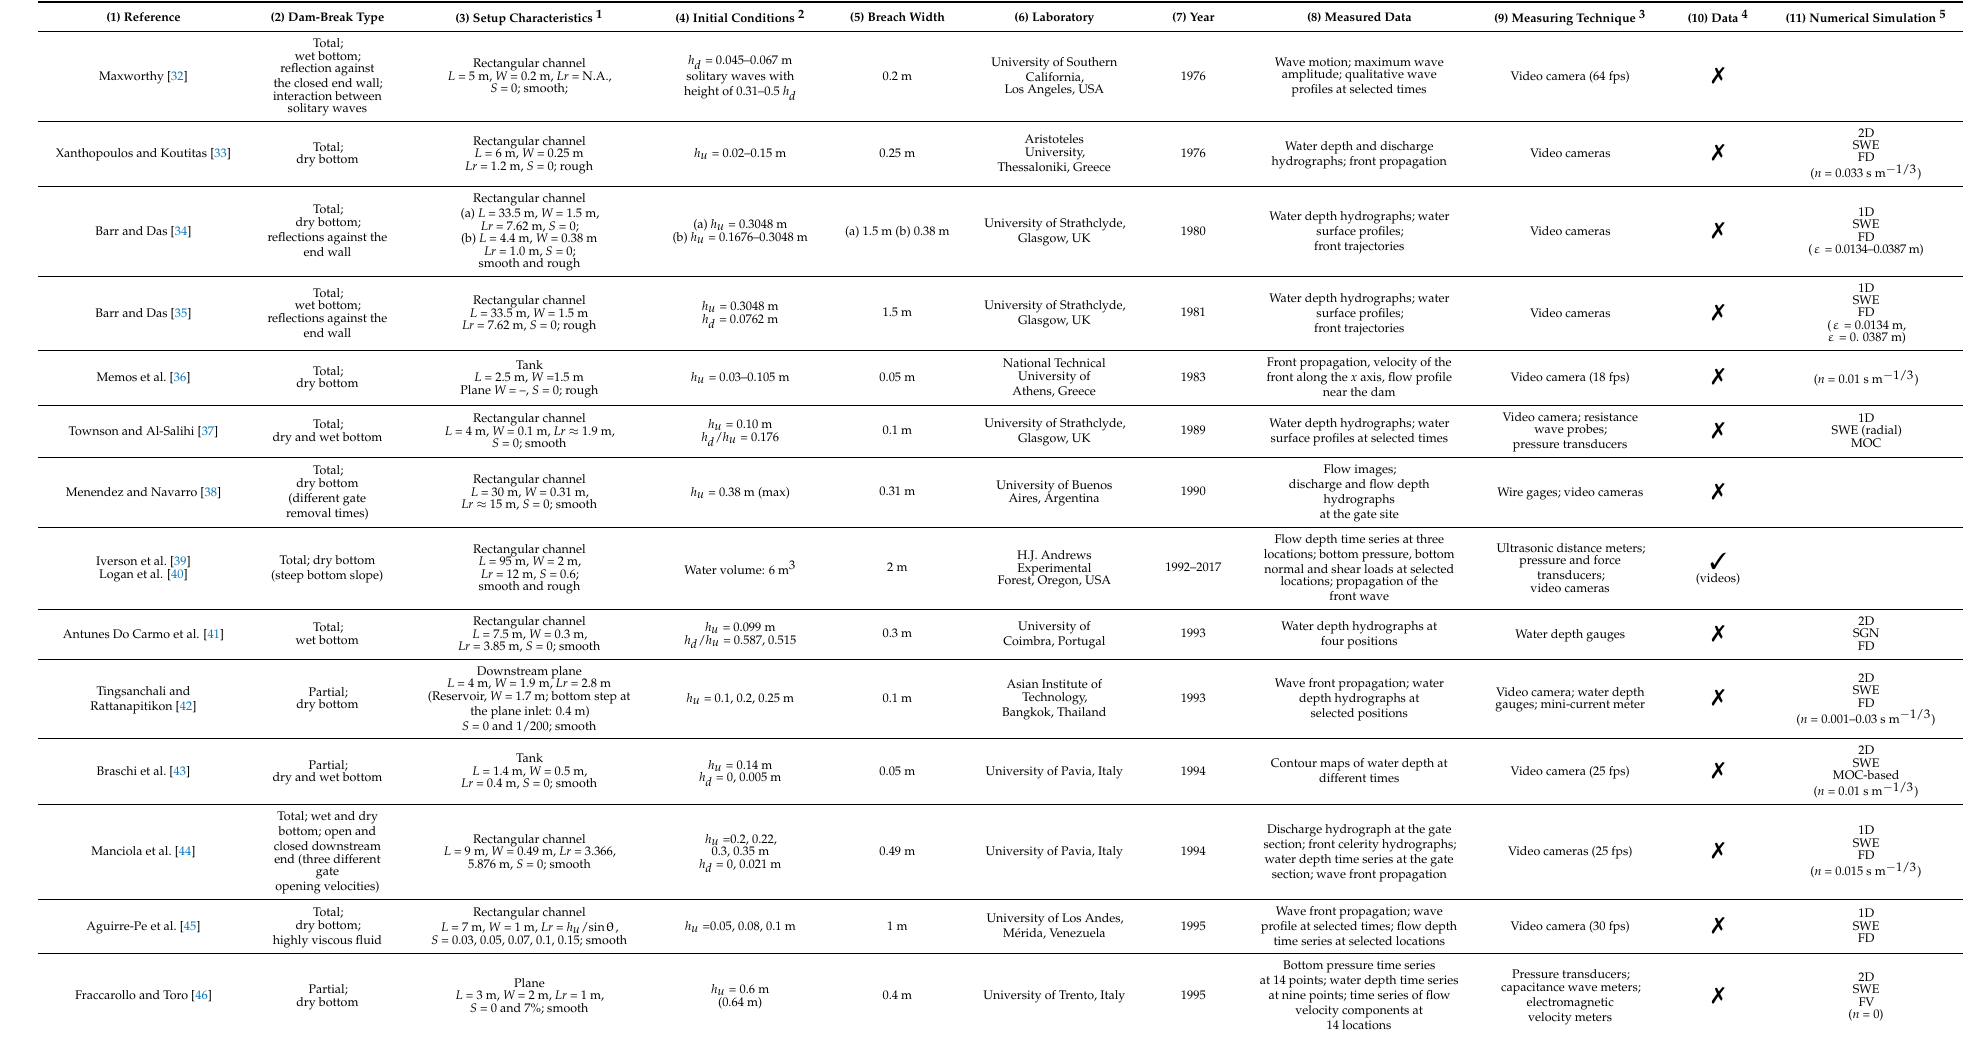
Table 1. Basic experimental investigations of fundamental dam-break wave physical characteristics.